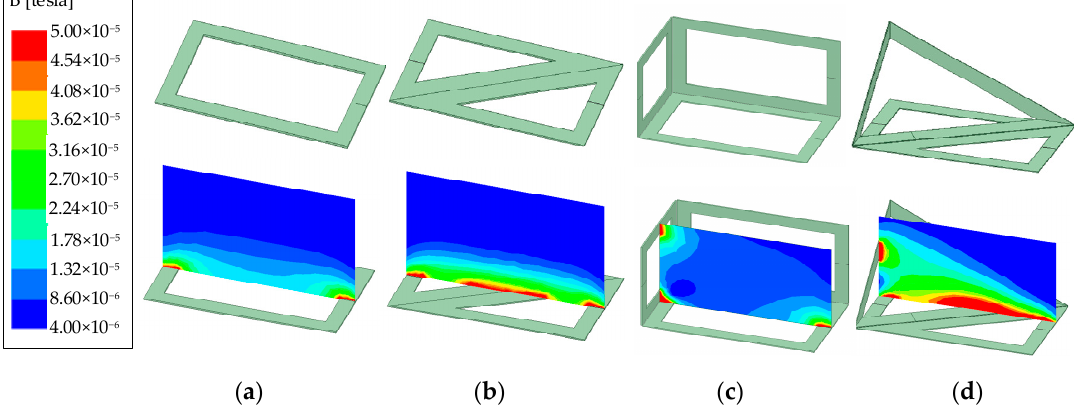
Figure 2. Different Tx coils with their respective magnetic field density simulations in the YZ vertical section. ( a ) Concentric spiral coil. ( b ) Bipolar DD coil. ( c ) Cubic 3D coil. ( d ) Proposed 3D coil.